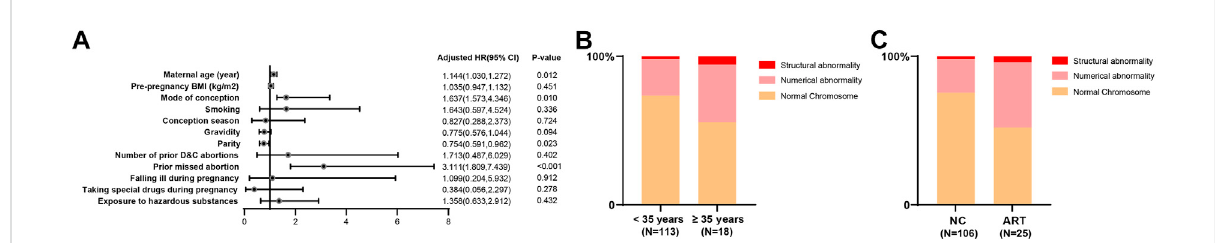
FIGURE 3 The maternal risk factors for embryonic chromosome abnormalities. (A) Binary logistic regression showed that ART and prior missed abortion increased the risk of embryonic chromosome abnormality by 1.6 and 3.1 times, respectively. Besides, with an increase in age by 1 year, the risk of embryonic chromosome abnormality increased by 14.4%; (B) 28 (24.8%) women had embryonic chromosomal numerical abnormalities and two (1.8%) had embryonic structural abnormalities in the normal age group, while seven (38.9%) had embryonic chromosomal numerical abnormalities and one (5.6%) had embryonic structural abnormalities in the advanced maternal age group; (C) 24 (22.6%) women had embryonic chromosomal numerical abnormalities and two (1.9%) had embryonic structural abnormalities in the natural conception group, whereas 11 (44.0%) had embryonic chromosome numerical abnormalities and one (4.0%) had embryonic structural abnormalities in the ART